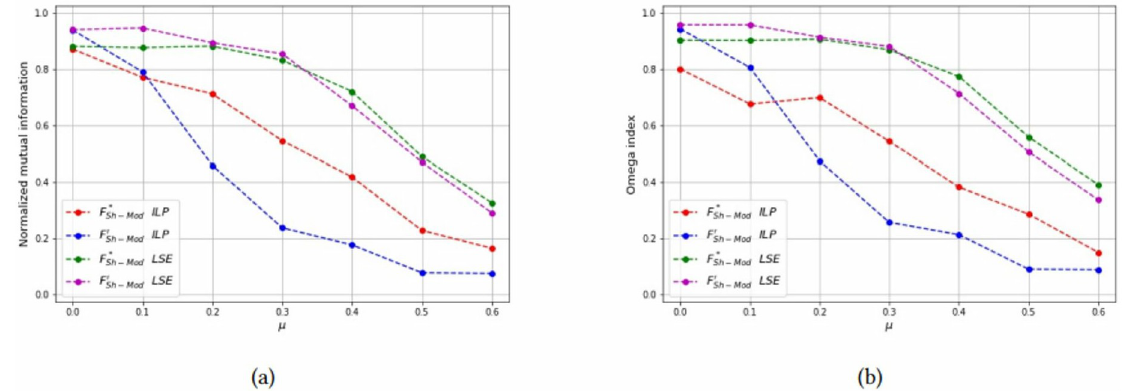
Fig 18. Test results on overlapping communities, parameters p = 2, μ o = 0.7, N o = 3. (a) Average NMI for each solution method, (b) Average Omega for each solution method.